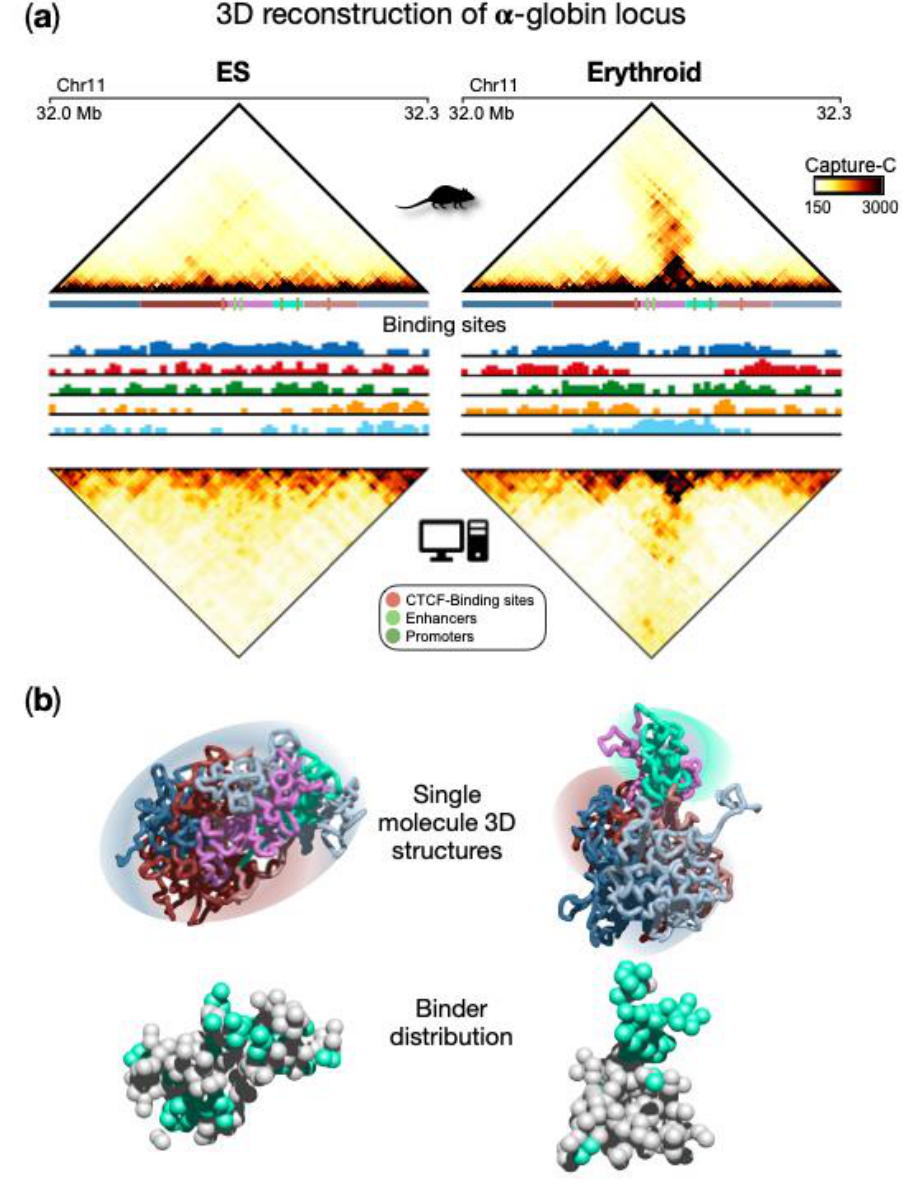
Figure 4. Polymer physics highlights regulatory linked conformations driven by micro-phase separa- tion in α-globin locus. ( a ) Upper panels: Capture-C contact data of the genomic region centered on the α-globin genes show a drastic change in the 3D organization of the locus in ESCs with respect to erythroid cells, where a strong stripe of interaction emerges. Bottom panels: contact data obtained from the ensemble of 3D conformations from Molecular Dynamics simulations of the SBS model; ( b ) Examples of single-molecule 3D structures in the two cell types highlight chromatin conforma- tional tissue-specificity: in ESCs, a large uniform domain with no preferential contact is observed, while in erythroid, evident domains form, one containing the globin genes and enhancers. Binder distributions are shown next to the polymer structure, binders associated with genes and enhancer are colored in cyan. Image adapted from [38].